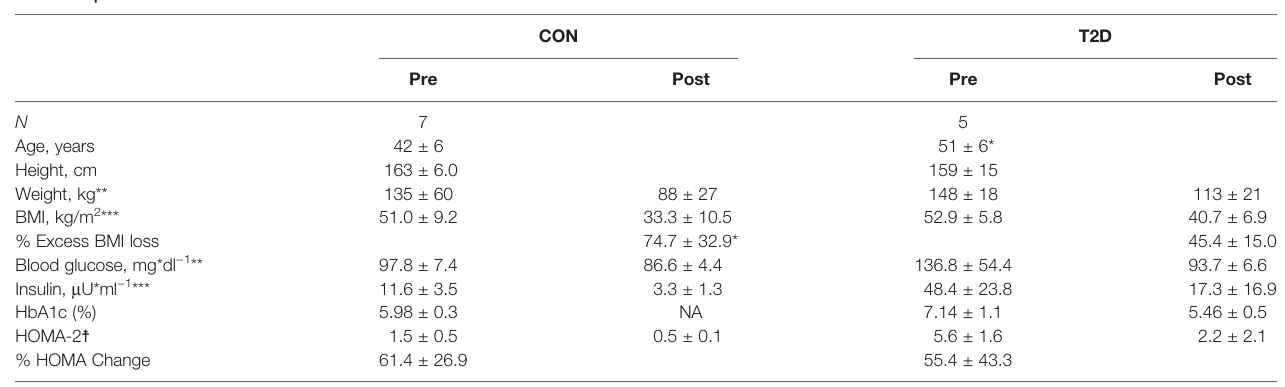
TABLE 1 | Clinical